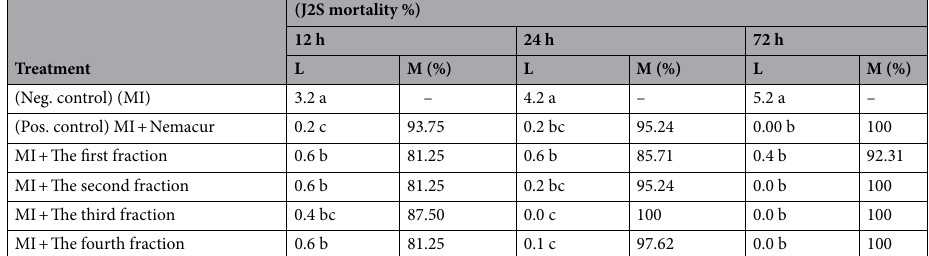
Table 5. The effects of C. sinuosa methylene chloride eluent fractions on J2S mortality % (M) of Meloidogyne incognita (MI) after 12, 24 and 72 h of exposure. Data are means of 5 replicates. Values followed by the same letter(s) are not significantly different at p ≤